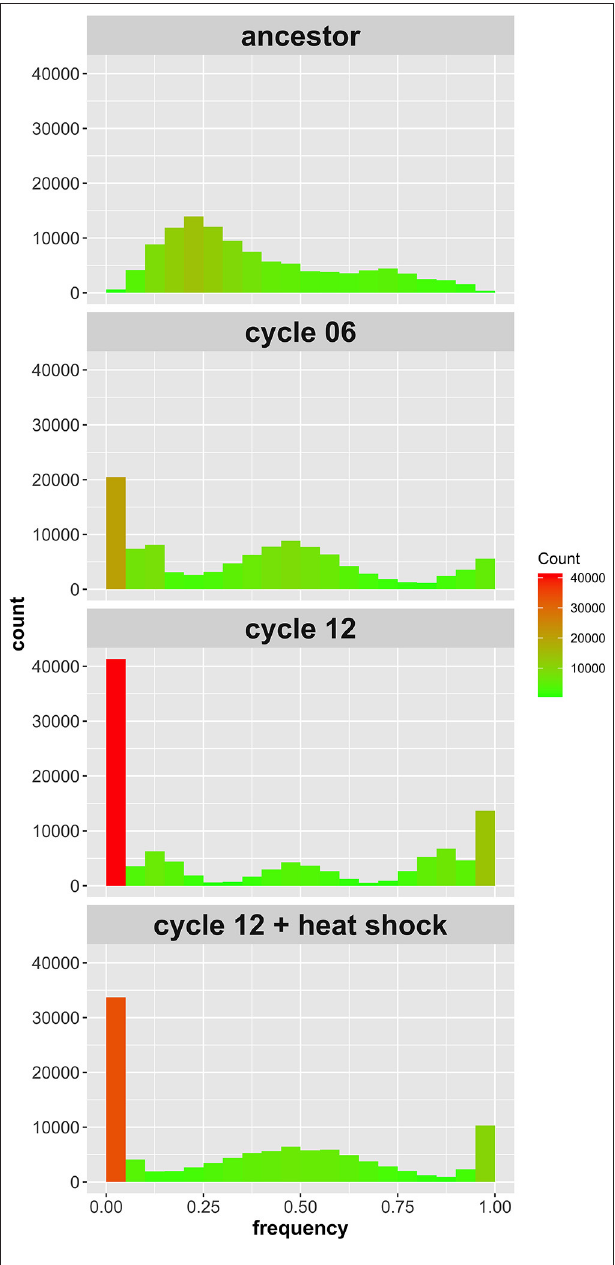
FIGURE 2 | Site frequency spectrum of SNPs identified in the 4-parent population initially, after six outcrossing events, after 12 outcrossing events, and after 12 outcrossing events + a heat shock of 55 ◦ C for 20min. Color in included in the histograms to emphasize the bins with high counts (red) compared to those with low counts (green); notice the reduction in sites with frequency = 0 or 1 between cycle 12 and cycle 12 + heat shock.